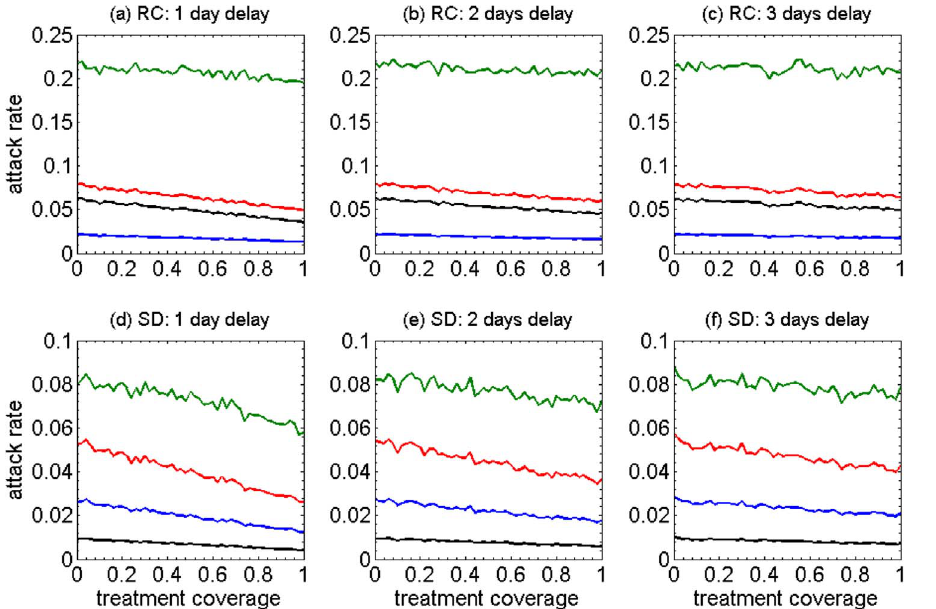
Figure 1. The impact of different coverages (0–100%) of antiviral treatment on the age-specific cumulative attack rates under different assumptions for the mean time between symptoms onset and the start of treatment (1–3 day delay). Panels a–c (RC) show results from the model representing the remote and isolated Canadian Aboriginal community, and panels d–f (SD) show results from the model representing a community with an urban-like shifted demographic structure. Green: School-aged children (6–18); red: adults (19–49); blue: older adults (50 + ); black: pre-school (0–5).